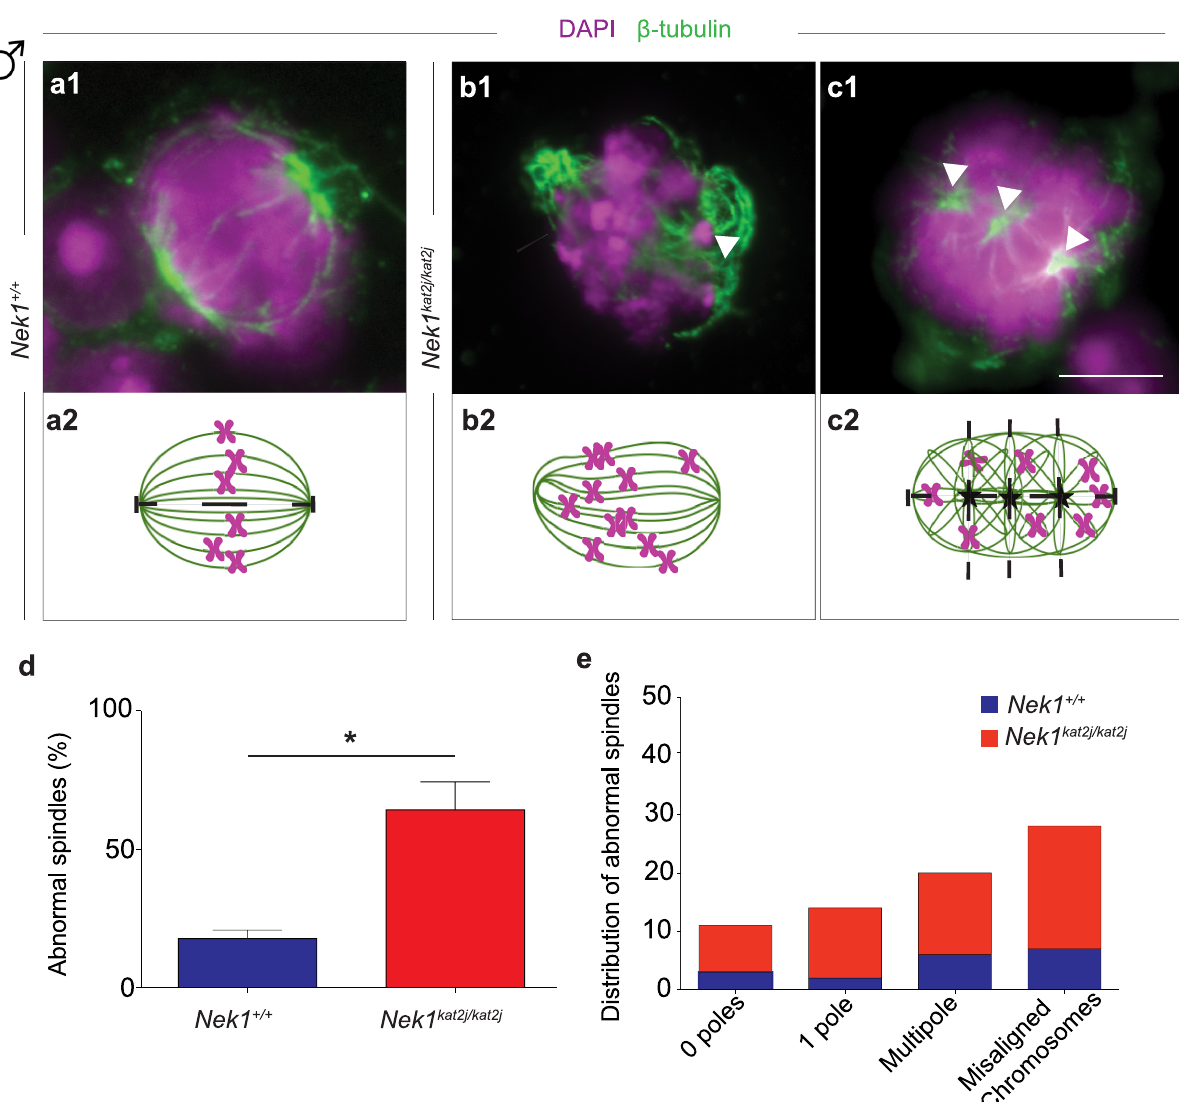
Fig 1. Loss of NEK1 results in disrupted spindle morphology and chromosome congression during meiosis I in spermatocytes. (a-c) Immunofluorescence (IF) against β -tubulin (green)and DNA stainingwith DAPI (magenta) showing meiotic spindlemorphology (panels a1-c1), with graphic representations below(panels a2-c2). (A) Nek1 +/+ spermatocyte shows normal spindlemorphologyand chromosomecongression at the midplate of the spindle; (b, c) Examples of aberrantspindlemorphologyin spermatocytes from Nek1 kat2j/ kat2j mice showingmonopolar spindleswith mislocalized chromosomesresultingfrom failed chromosomecongression (arrowheads)in b and multipolarspindlesin c (arrowheads). (d) Quantitation of abnormalspindlesin spermatocytes from Nek1 +/+ and Nek1 kat2j/kat2j mice (n = 100 cells countedfor each). (e) Quantitationcells with abnormal spindlesby type of defect. Values are percentages ± Standard deviation. * Indicates statistically significantdifferences (Unpaired t-test p <